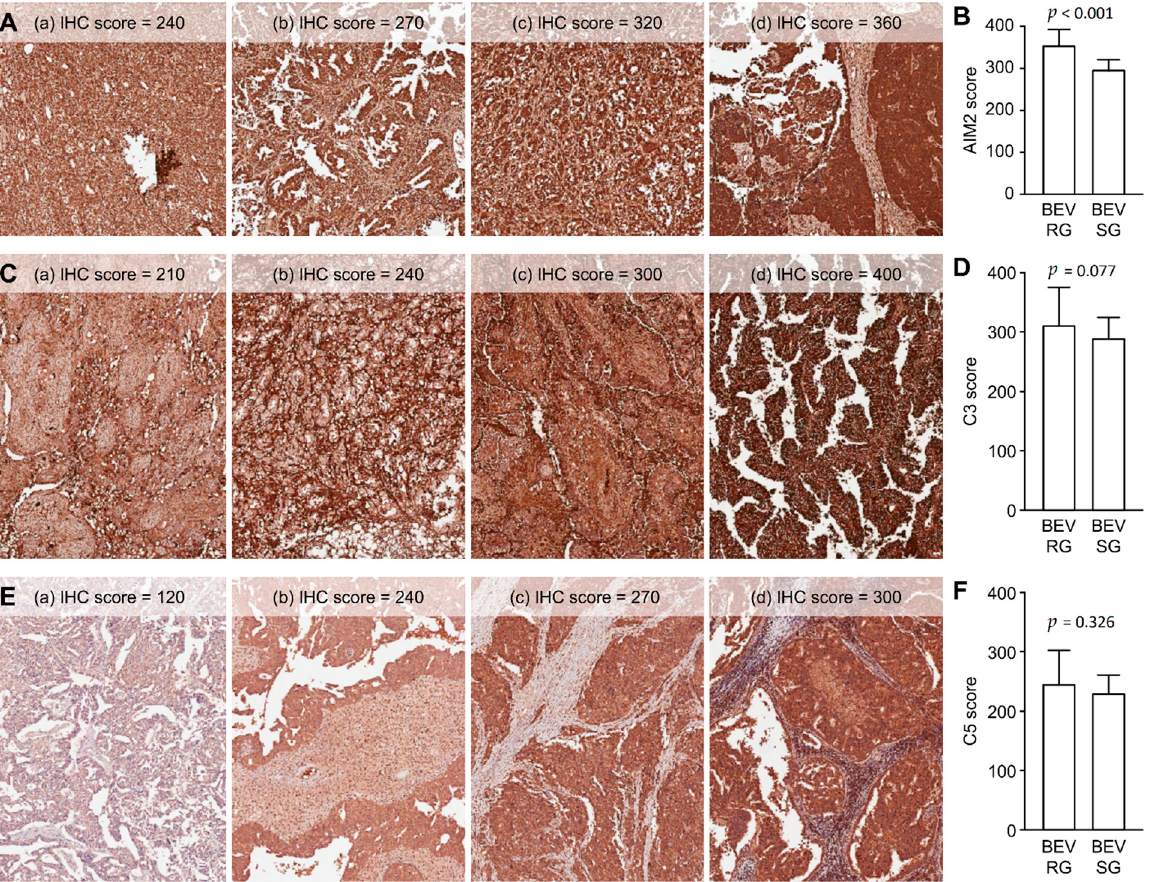
Figure 2. ( A ) Examples of immunohistochemistry (IHC) staining for AIM2 in tumor cells. ( a ) IHC score = +3 × 80%; ( b ) IHC score = +3 × 90%; ( c ) IHC score = +4 × 80%; ( d ) IHC score = +4 × 90%. ( B ) Semiquantitative comparison of AIM2 immunostaining scores between the bevacizumab-resistant group (BEV RG) and bevacizumab-sensitive group (SG). ( C ) Examples of IHC staining for C3 in tumor cells. ( a ) IHC score = +3 × 70%; ( b ) IHC score = +3 × 80%; ( c ) IHC score = +3 × 100%; ( d ) IHC score = +4 × 100%. ( D ) Semiquantitative comparison of C3 immunostaining scores between the BEV RG and SG. ( E ) Examples of IHC staining for C5 in tumor cells. ( a ) IHC score = +2 × 60%; ( b ) IHC score = +3 × 80%; ( c ) IHC score = +3 × 90%; ( d ) IHC score = +3 × 100%. ( F ) Semiquantitative comparison of C5 immunostaining scores between the BEV RG and SG. * Absolute IHC score = intensity multiplied by percentages of stained cells.